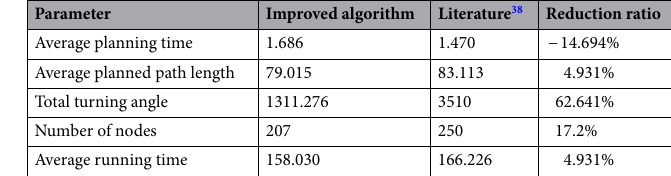
Table 6. Comparison of multi-objective